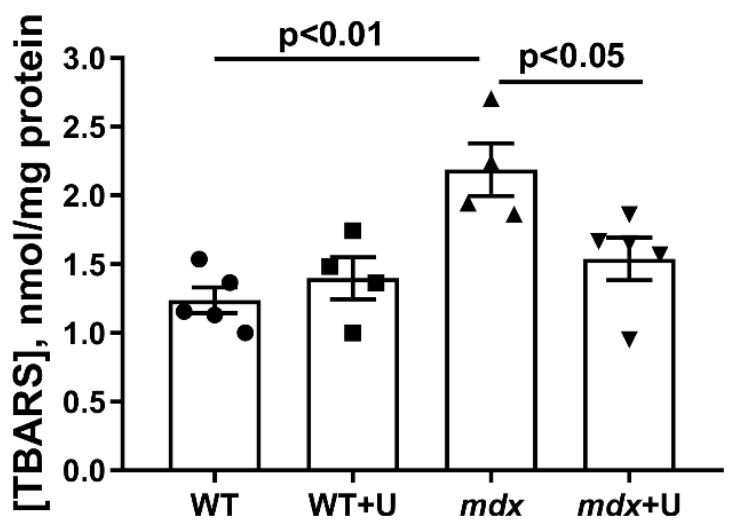
Figure 7. The effect of uridine on lipid peroxidation in mitochondria. Lipid peroxidation was as- sessed by the level of TBARS (mainly represented by MDA) in the skeletal muscle mitochondria of experimental groups of animals. The data are presented as means ± SEM ( n = 4–5).